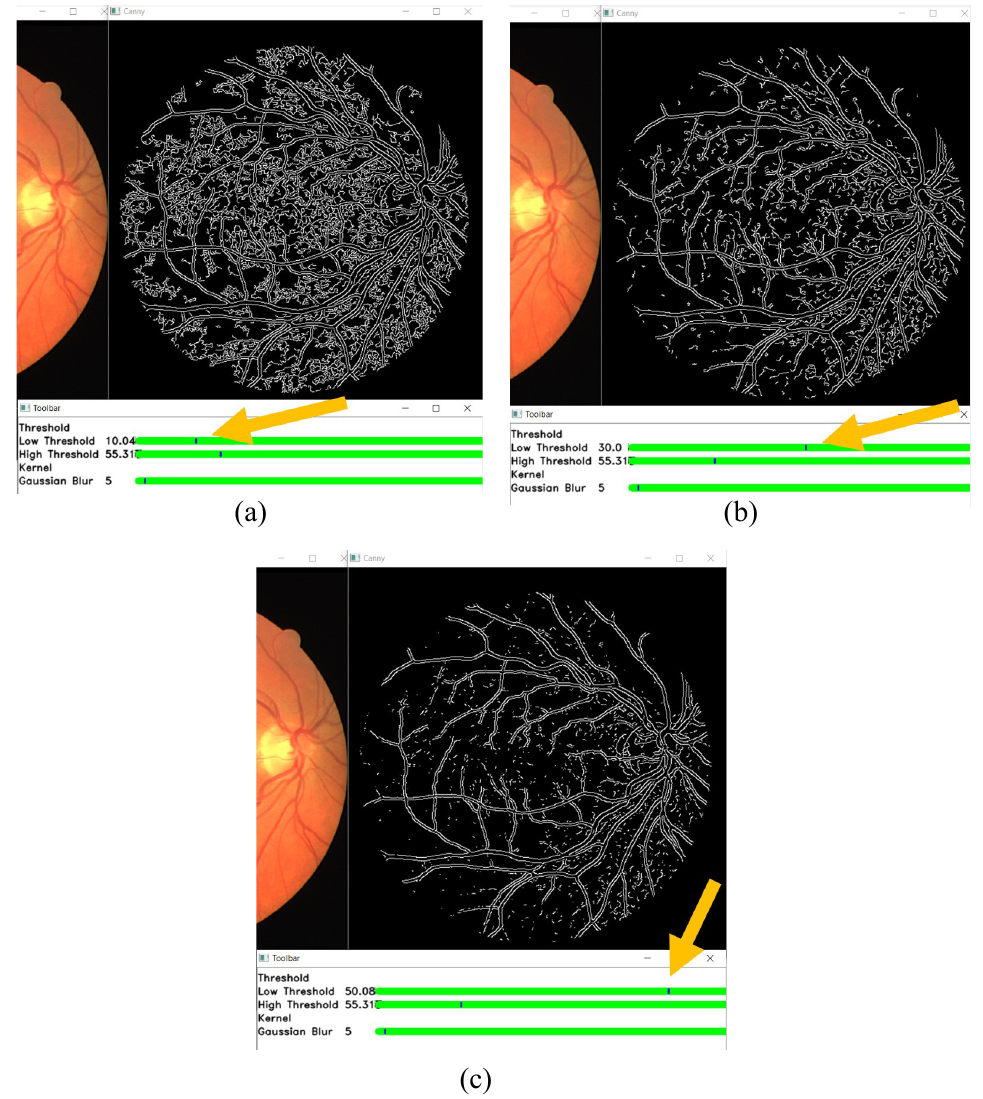
Figure 9. High threshold at 55, and low threshold at ( a ) 10 (the obtained PFOM value is 0.4739), ( b ) 30 (the obtained PFOM value is 0.5448), and ( c ) 50 (the obtained PFOM value is